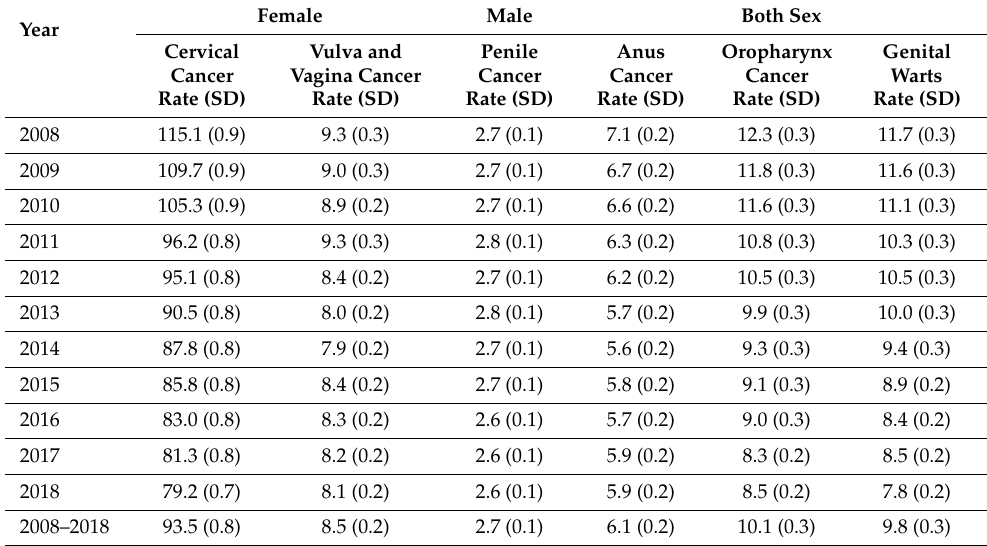
Table 2. Hospitalization rates due to HPV-related diseases per 100,000 inhabitants in Italy